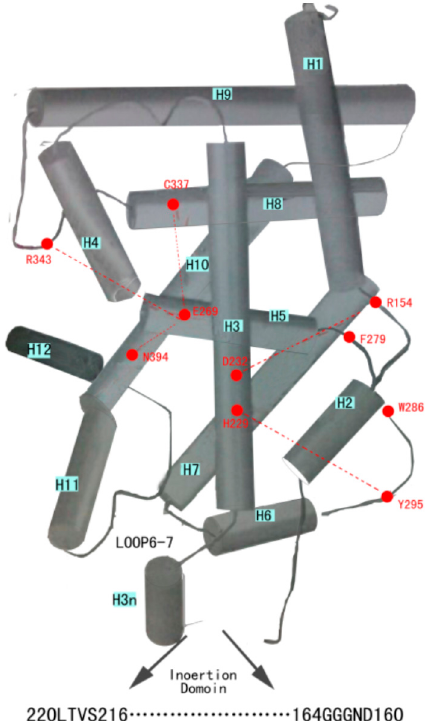
Figure 2. Important amino acid residues. There are 10 important amino acid residues which have a greater role in stabilizing the sandwich structure of VDR LBD with no-ligand. There is a center crossing of H3 with H5. D232 and H229 of H3 form hydrogen bonds with R154 (just behind H1) and Y295 ( β -sheet just in front of H6) respectively. E269 (H5) is connected by hydrogen bond to C337 (H8), R343 (coil between H8 and H9), and N394 (H10). The β -sheet between H5 and H6 originates from a strong hydrophobic interaction formed by F279 ( β -sheet just behind H5) and W286 ( β -sheet in front of H6).